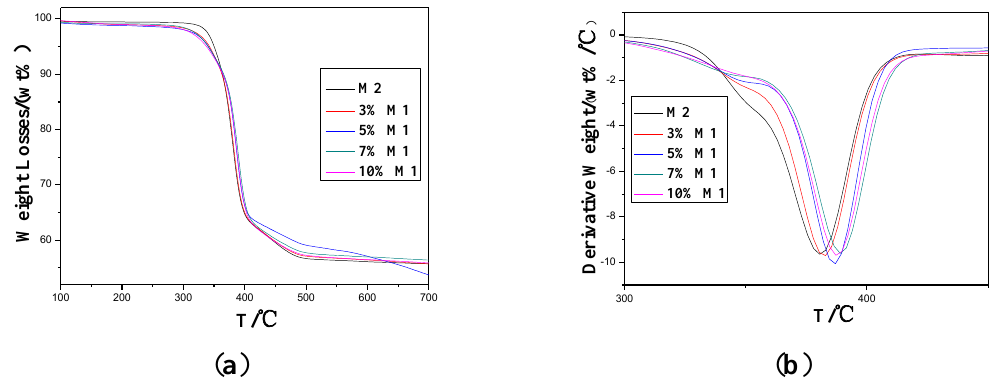
Figure 4. Isothermal TG curves ( a ) of blends of different content of M1 as a function of cure temperature and DTG ( b ) curve of the compositions.